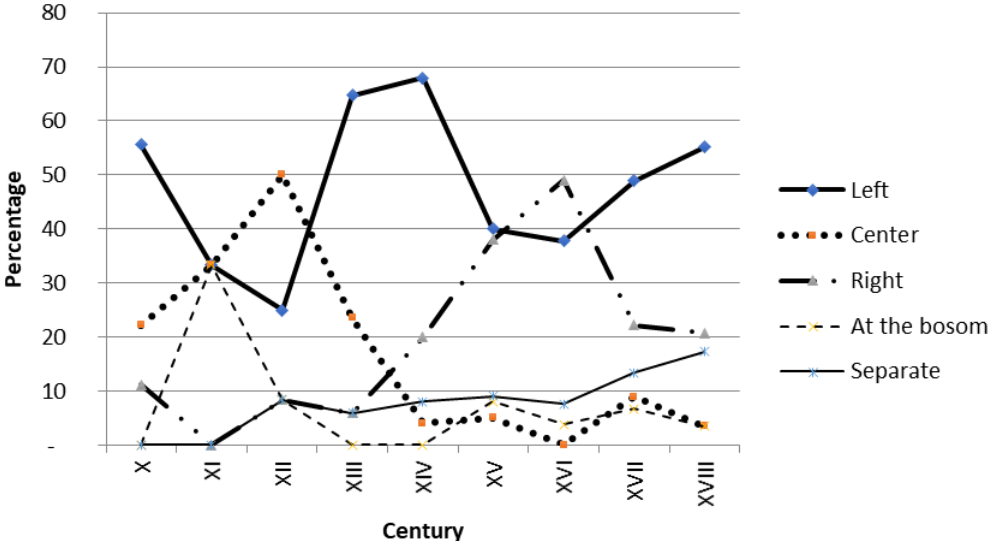
Figure 10. The Christ Child’s position in relation to Mary (Spain, tenth to eighteenth centuries). Source: Authors’ elaboration based on Trens (1946).